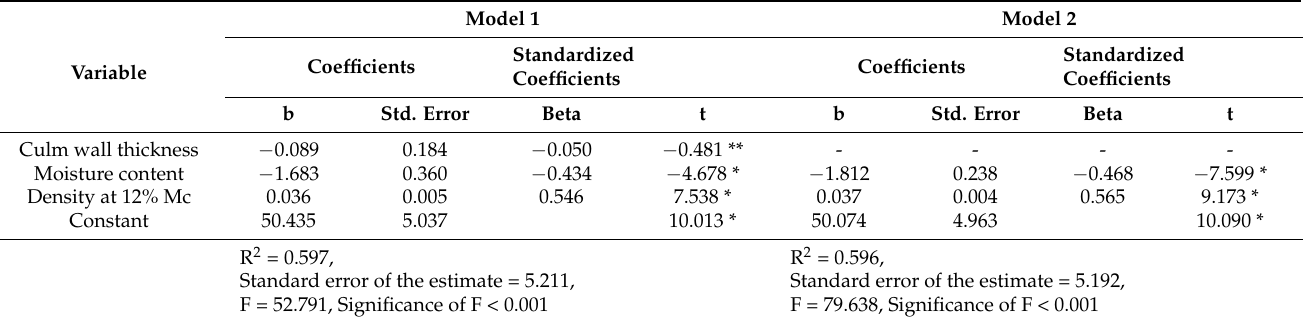
Table 5. Multiple linear regression analysis for the dependent variable maximum compressive strength ( σ u